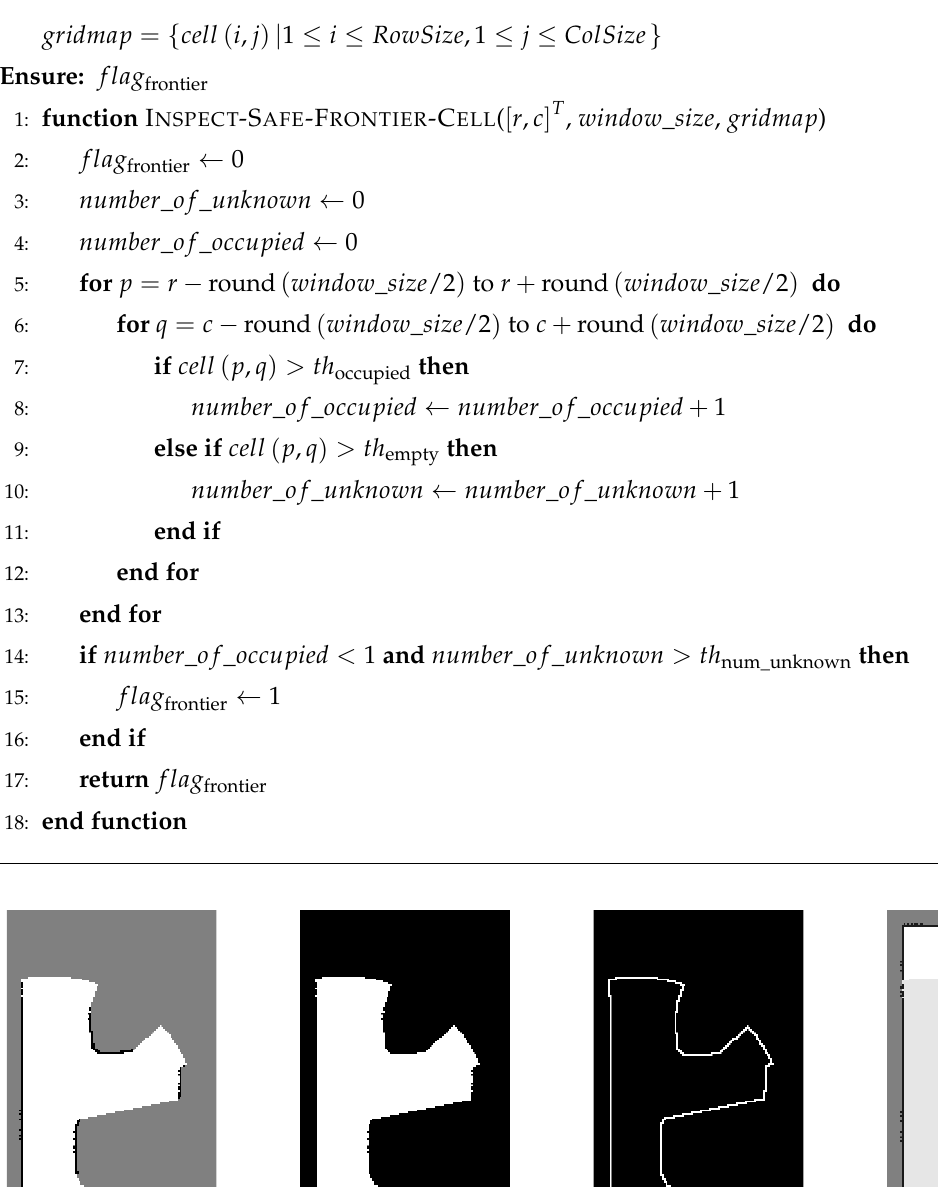
Algorithm 3 Safety inspection of a frontier cell